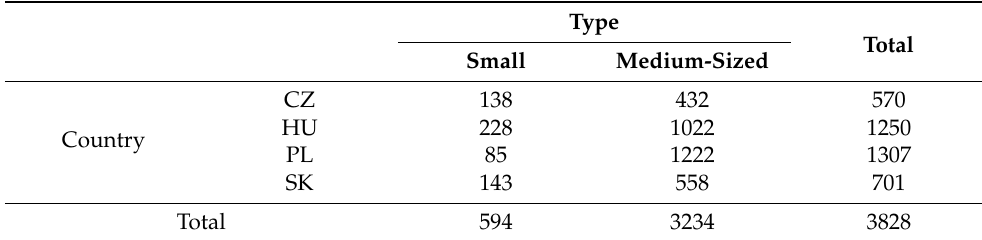
Table 1. Total sample.